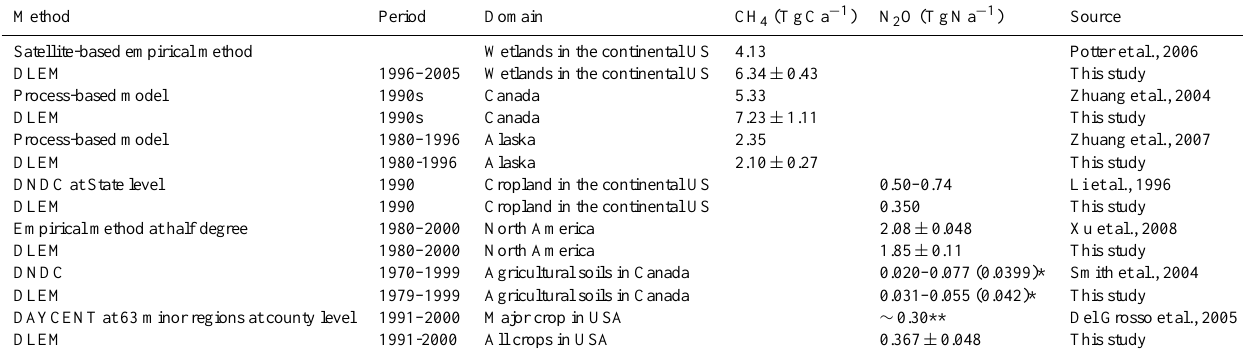
Table 7. Comparison of the DLEM-derived CH 4 and N 2 O fluxes with other estimates at the regional scale (DLEM simulations were at a resolution of 32km × 32km).